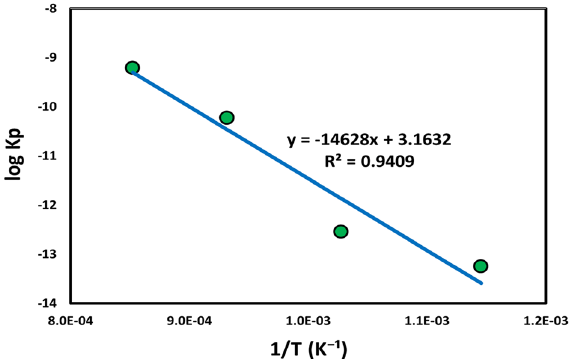
Figure 4. Arrhenius equation represents parabolic constant (log K p ) with temperature (1/T) for thermal oxidation at 600–900 °C for 50 h.